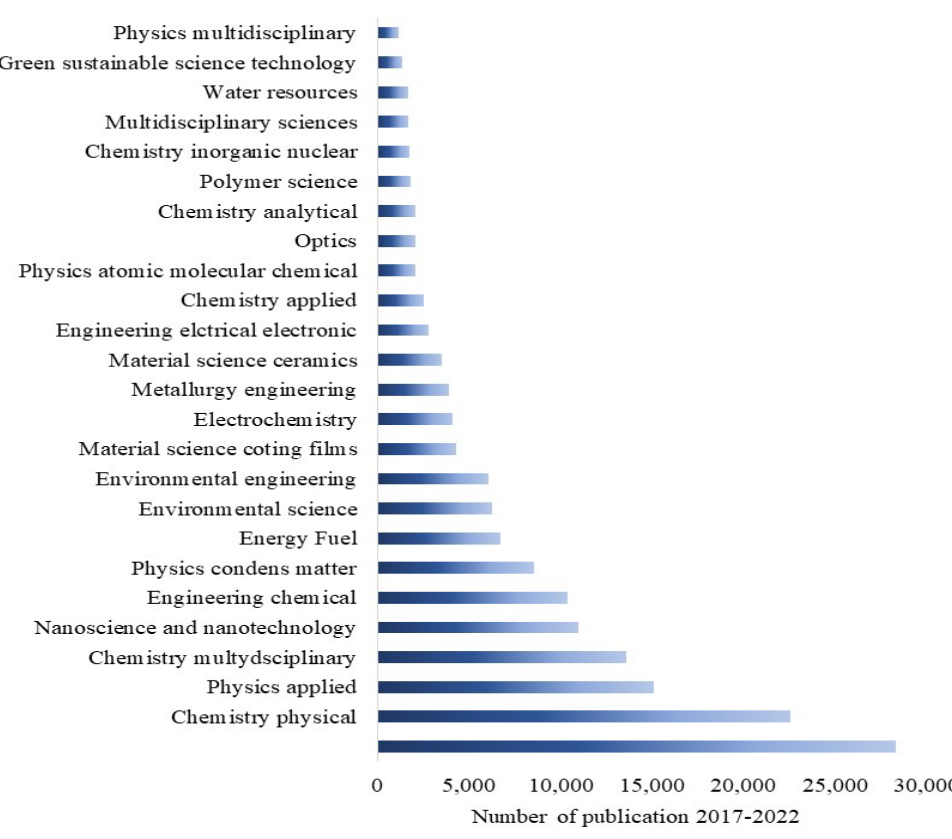
Figure 1. The widespread publications on TiO 2 in various research fields in the last five years. Resource: Web of Science.